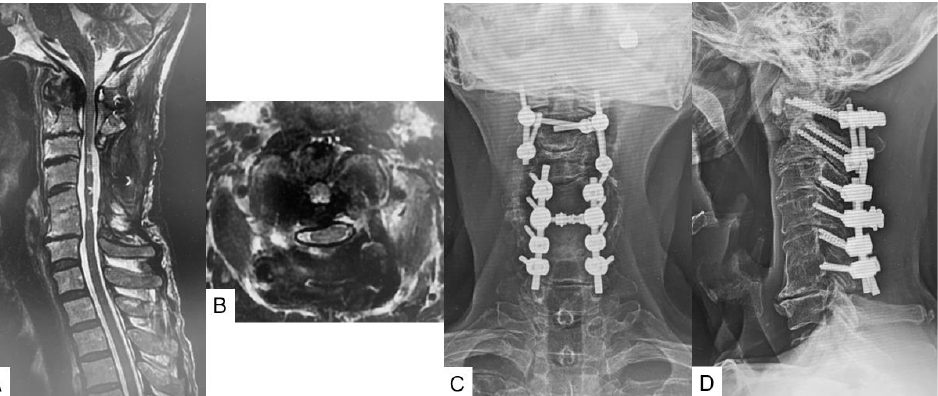
Figure 4. Follow-up images, ( A ): mid-sagittal T2-weighted MR imaging, ( B ): axial T2-weighted MR imaging at C1–2, ( C ): anteroposterior radiogram, ( D ): lateral radiogram.